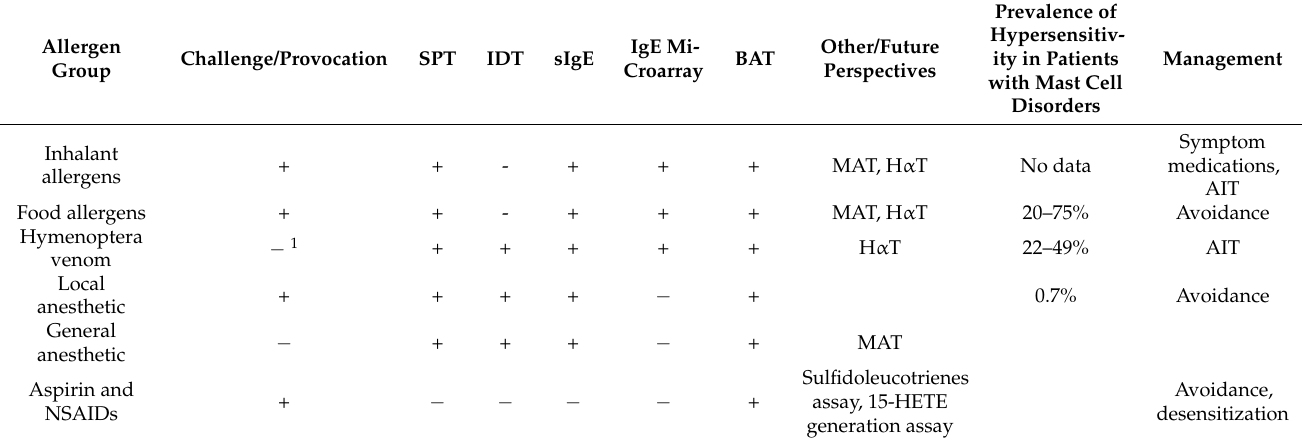
Table 1. Test and methods used in hypersensitivity diagnosis in patients with mast cell disorders. SPT—Skin Prick Test; IDT—Intradermal Test; BAT—Basophil Activation Test; MAT—Mast cell Activation Test; NSAIDs—Non steroid anti-inflammatory drugs; AIT—Allergen Immunotherapy [7,23,30–32,44–46,53,63,64,66,67,79–82,90,91,108,109].